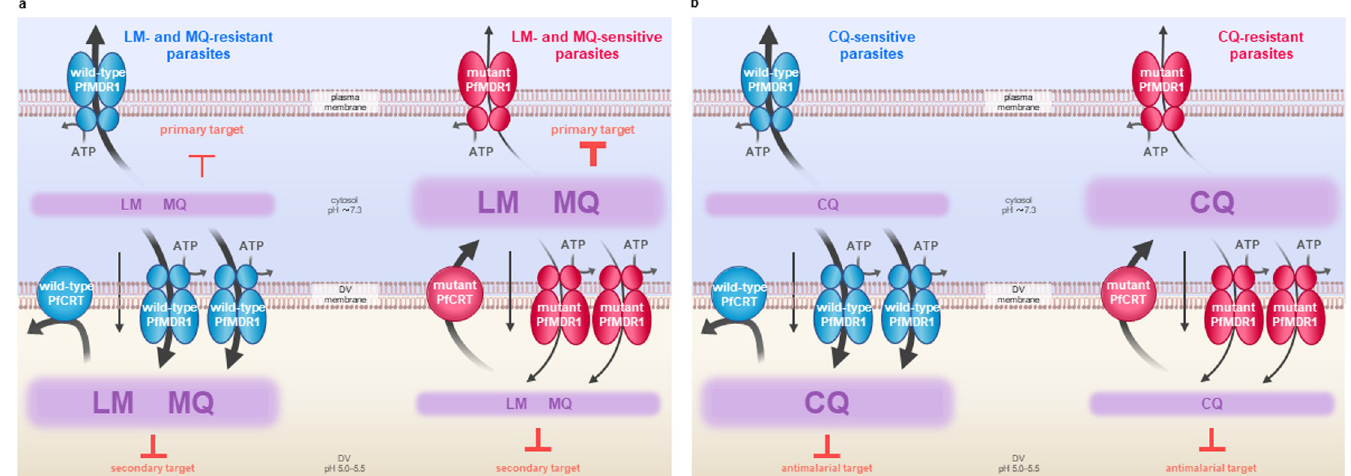
Fig 7. Roles of PfMDR1 and PfCRT in the parasite’s susceptibility to lumefantrine, mefloquine, and chloroquine. Mechanistic explanations for how polymorphisms in pfmdr1 and pfcrt alter the parasite’s response to lumefantrine and mefloquine (a) and chloroquine (b) . Lumefantrine, mefloquine, and chloroquine are weak bases that enter the DV via 2 main routes: (1) simple diffusion of the neutral species across the membrane and subsequent protonation within the acidic DV lumen; and (2) ATP-driven import via PfMDR1. Wild-type PfMDR1 has a high capacity for drug transport and this activity, together with the inability of wild-type PfCRT to efflux lumefantrine, mefloquine, or chloroquine from the DV, causes these drugs to sequester within the DV. Overexpression of PfMDR1 results in a further increase in the rate of drug transport from the cytosol into the DV and thus greater accumulation of lumefantrine, mefloquine, and chloroquine in the DV (as well as concomitant reductions in their cytosolic concentrations). In parasites carrying a mutant PfMDR1 isoform (and/or only one pfmdr1 copy) as well as a mutant isoform of PfCRT, there is a marked reduction in the DV accumulation of lumefantrine, mefloquine, and chloroquine as a result of (1) a decrease in the rate of drug import via PfMDR1; and (2) the PfCRT-mediated efflux of drugs from the DV back into the cytosol. The reduction in the concentration of chloroquine at its primary site of action allows the parasite to evade its killing effects, thereby causing chloroquine resistance. On the other hand, the concomitant increases in the cytosolic drug concentrations render these parasites more sensitive to lumefantrine and mefloquine, indicating that the primary targets of both drugs are located outside of the DV. CQ, chloroquine; DV, digestive vacuole; LM, lumefantrine; MQ, mefloquine; PfCRT, Plasmodium falciparum chloroquine resistance transporter; PfMDR1, Plasmodium falciparum multidrug resistance protein